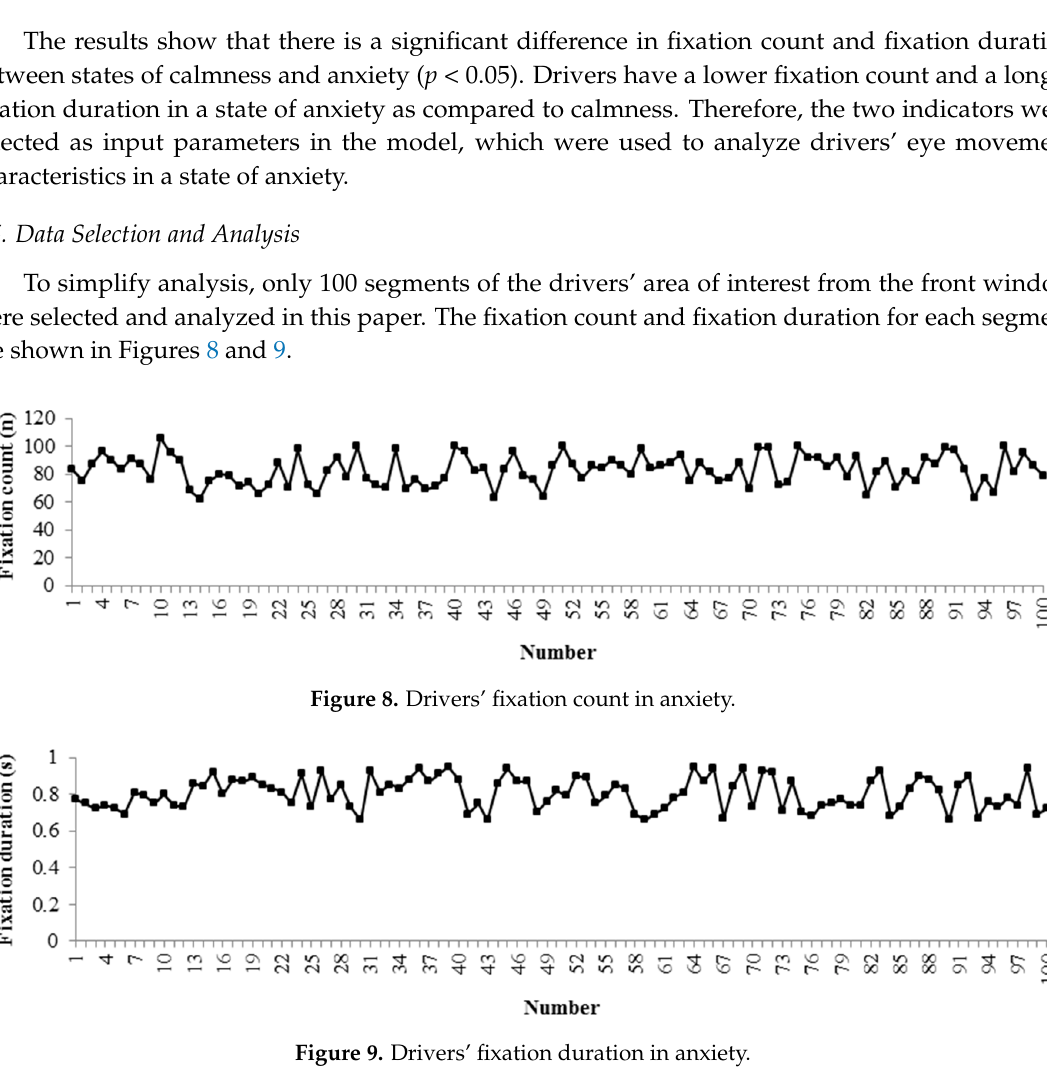
Figure 10. The flow of least squares algorithm. 3. Results and Discussion Tables 5 and 6 show the analysis results of the fixation count and fixation duration using the least squares method. Because the algorithm yields a strong sensitivity for eye movement data, a significance level of α = 0.001 was selected, and β = 1.01 was chosen to control the number of simulation cycles. Table 5. The hypothesis test results by the least squares method. Index